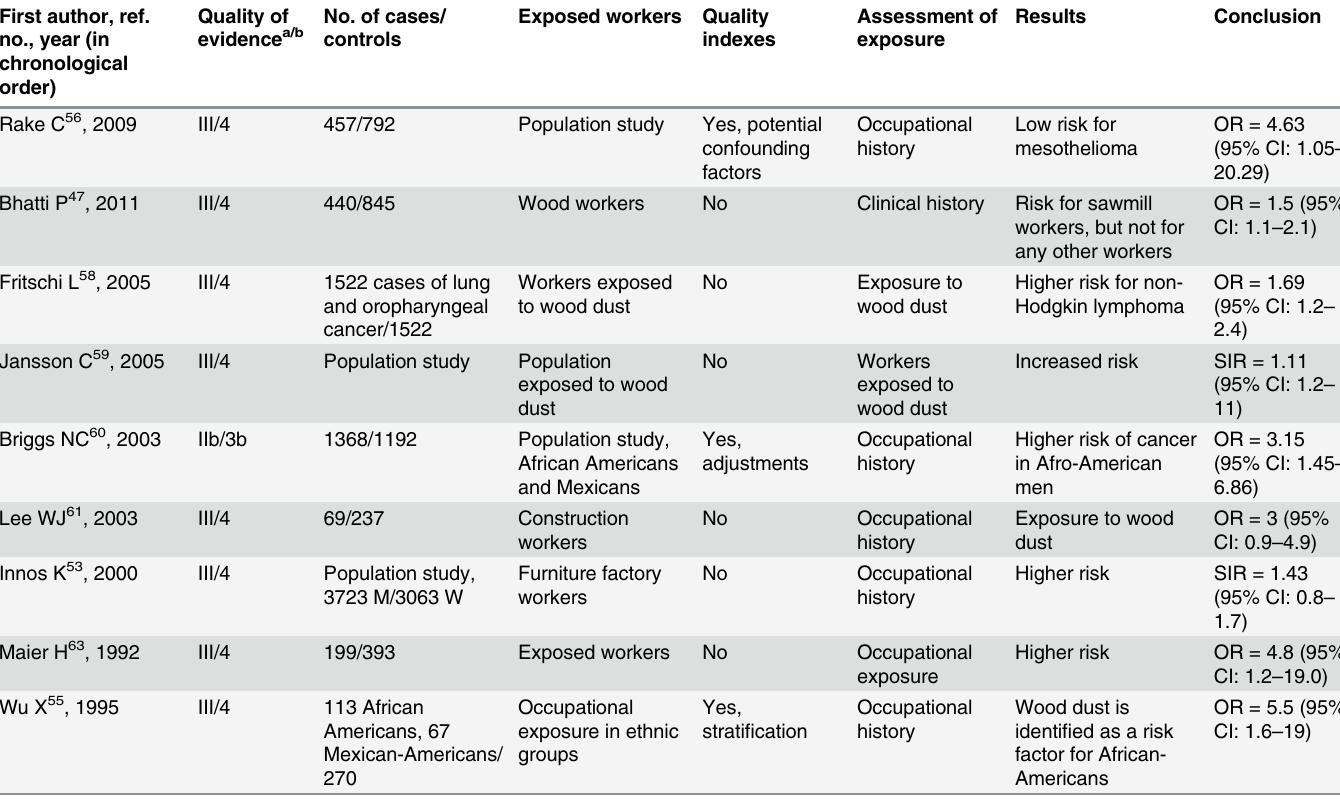
Table 2. Summary of published results on the relation between exposure to wood dust and lung cancer. First author, ref. no., year